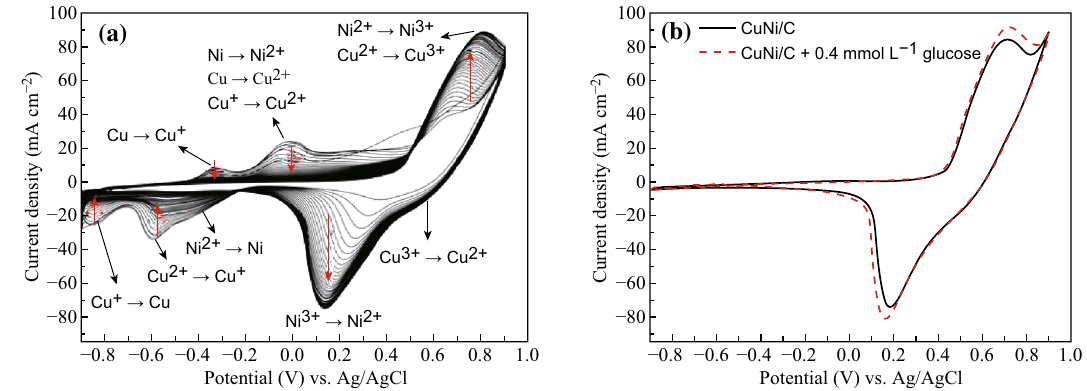
Fig. 5 a Activated CuNi/C electrodes in 0.1 M NaOH by CV for 60 cycles. b CVs of activated electrodes in 0.1 M NaOH and 0.1 M NaOH + 0.4 mM glucose. The CV measurements are performed in a three-electrode system by using Pt foil as counter electrode, and Ag/AgCl as a reference electrode. The scan rate is 20 mV s −